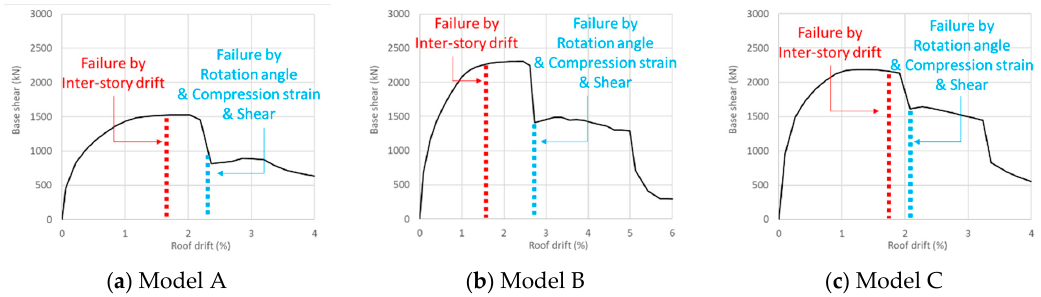
Figure 13. Result of pushover analysis and location of failure.